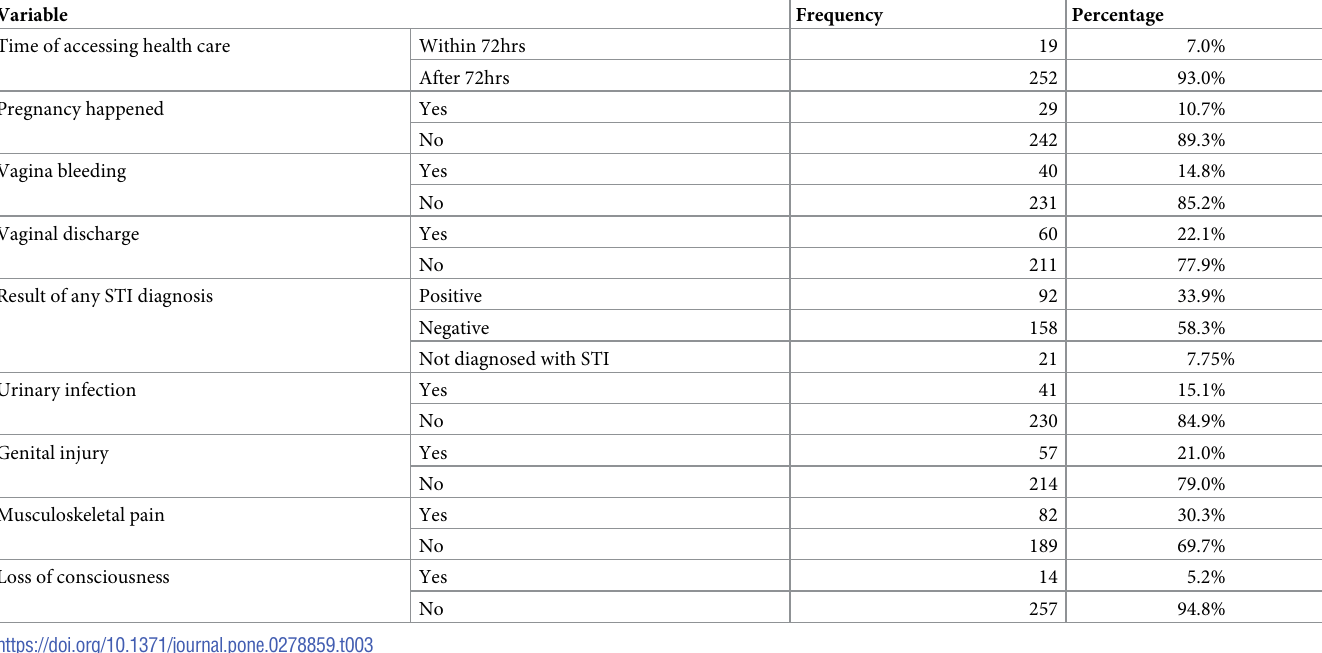
Fig 2. Sexually transmitted infections survivors exposed in Northeast Ethiopia, 2022 (n = 92). https://doi.org/10.1371/journal.pone.0278859.g002 Table 3. Medical consequences of rape among victim women during armed conflicts in Northeast Ethiopia, 2022 (n = 271).